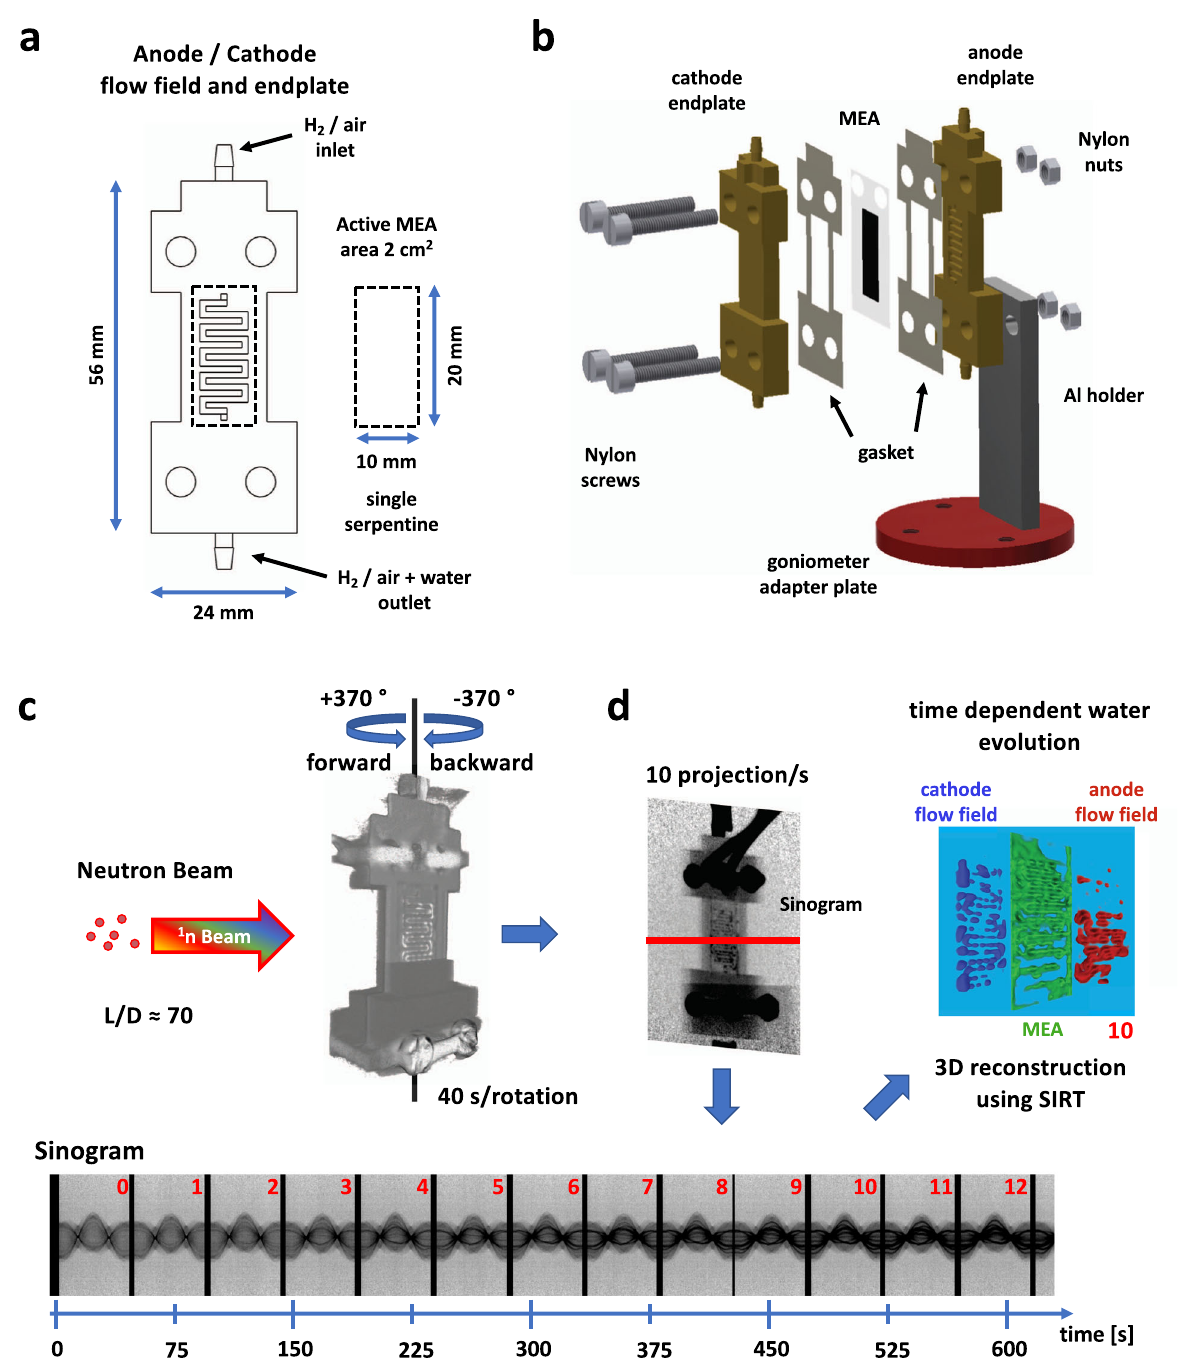
Fig. 1 Single serpentine fl ow fi eld design, fuel cell and imaging processing. a The fl ow fi eld design incorporated in the cell endplates for both anode and cathode with hydrogen and air in- and outlets, respectively. b Cell assembly on the rotation stage using nylon screws and nuts. c Tomograms were collected in 40 s during each of ±370° forward and backward rotations in the neutron beam with an L/D collimation of ca. 70. d Data processing, including fl at fi elding projections, generation of time-dependent sinograms (below) with water volume build-up (increasingly dark grey values from 0 to 12), 3D reconstruction, followed by water quanti fi cation in the anode and cathode fl ow fi elds, and in the